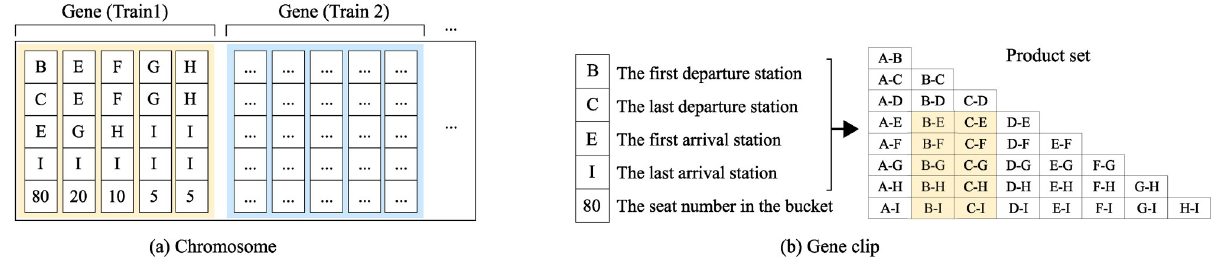
Fig 11. Chromosome and gene in a